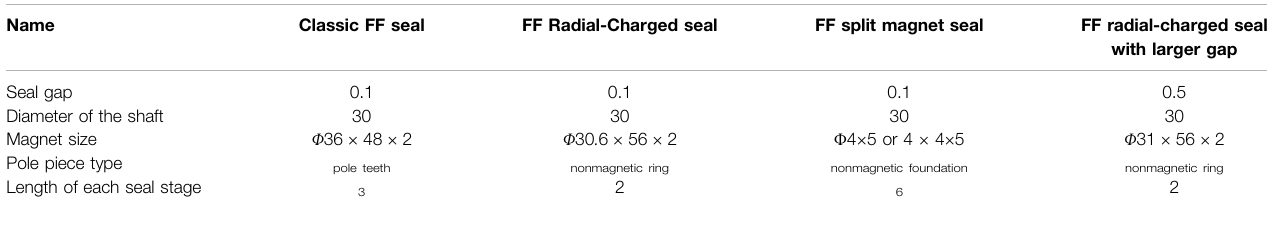
TABLE 1 | Relevant size